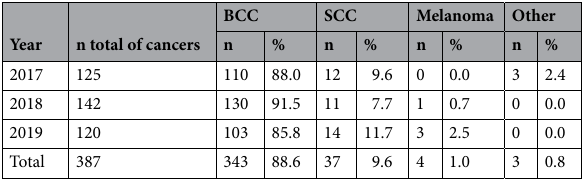
Table 2. Occurrence of most common types of skin cancers across 2017–2019. BCC basal cell carcinoma, SCC squamous cell carcinoma.